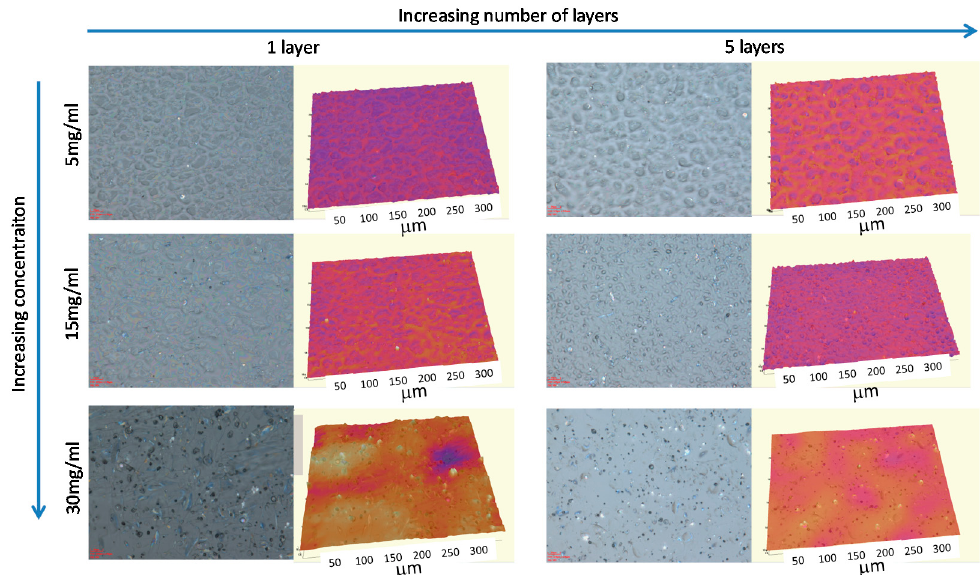
Figure 2. Optical microscope images and 3D optical profile images of the glass surfaces, sprayed using PS/CDCl 3 solutions at different concentrations: 5, 15 and 30 mg/mL. In addition, either one or five layers were sprayed onto the surface.